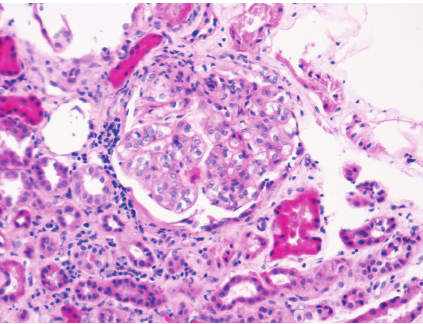
Figure 1: Kidney biopsy obtained on first admission showing hypercellular glomeruli with membranous